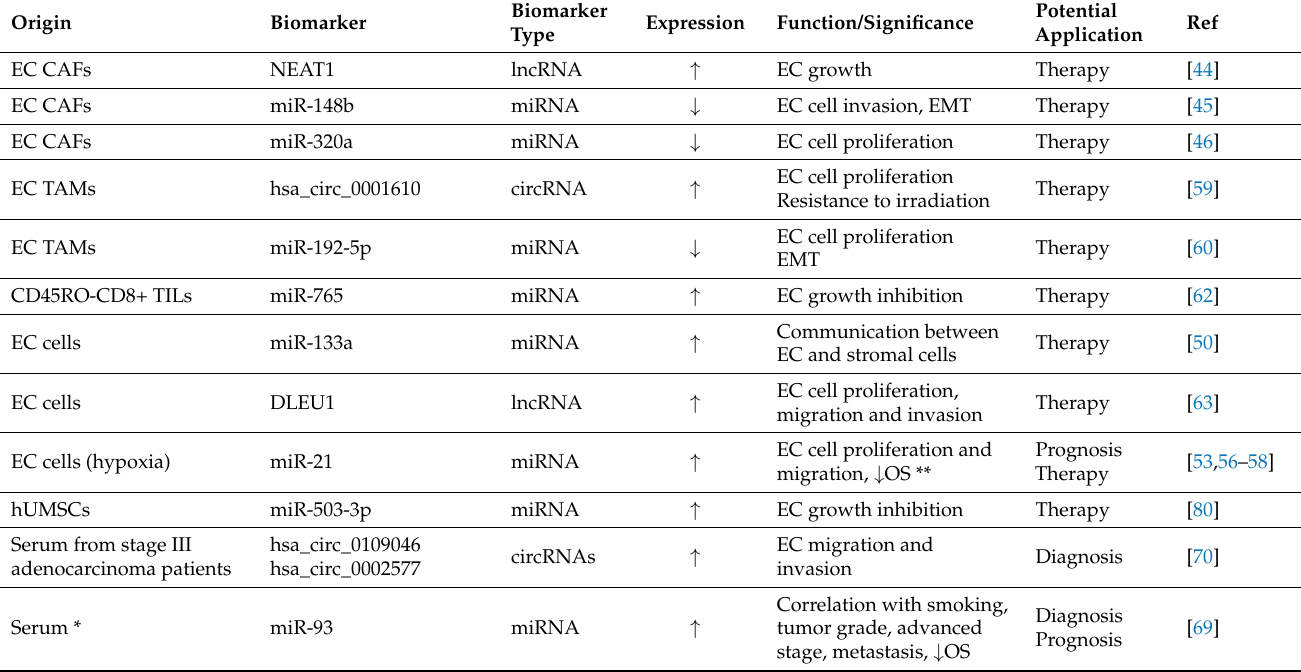
Table 1. Exosomal biomarkers in endometrial